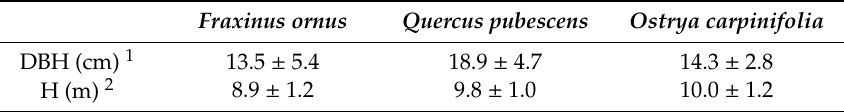
Table 1. Characteristics of the sampled trees. Mean values ± standard